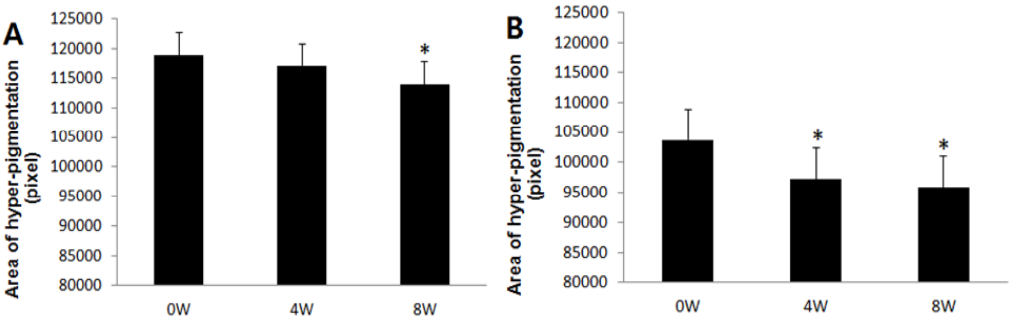
Figure 7. Changes in hyperpigmentation area following 8 consecutive weeks’ use of corn silk extract (mean ± SEM, * p < 0.05 vs. before treatment). ( A ) corn silk extract 0.75% aqueous solution; ( B ) corn silk extract 1.5% aqueous solution.